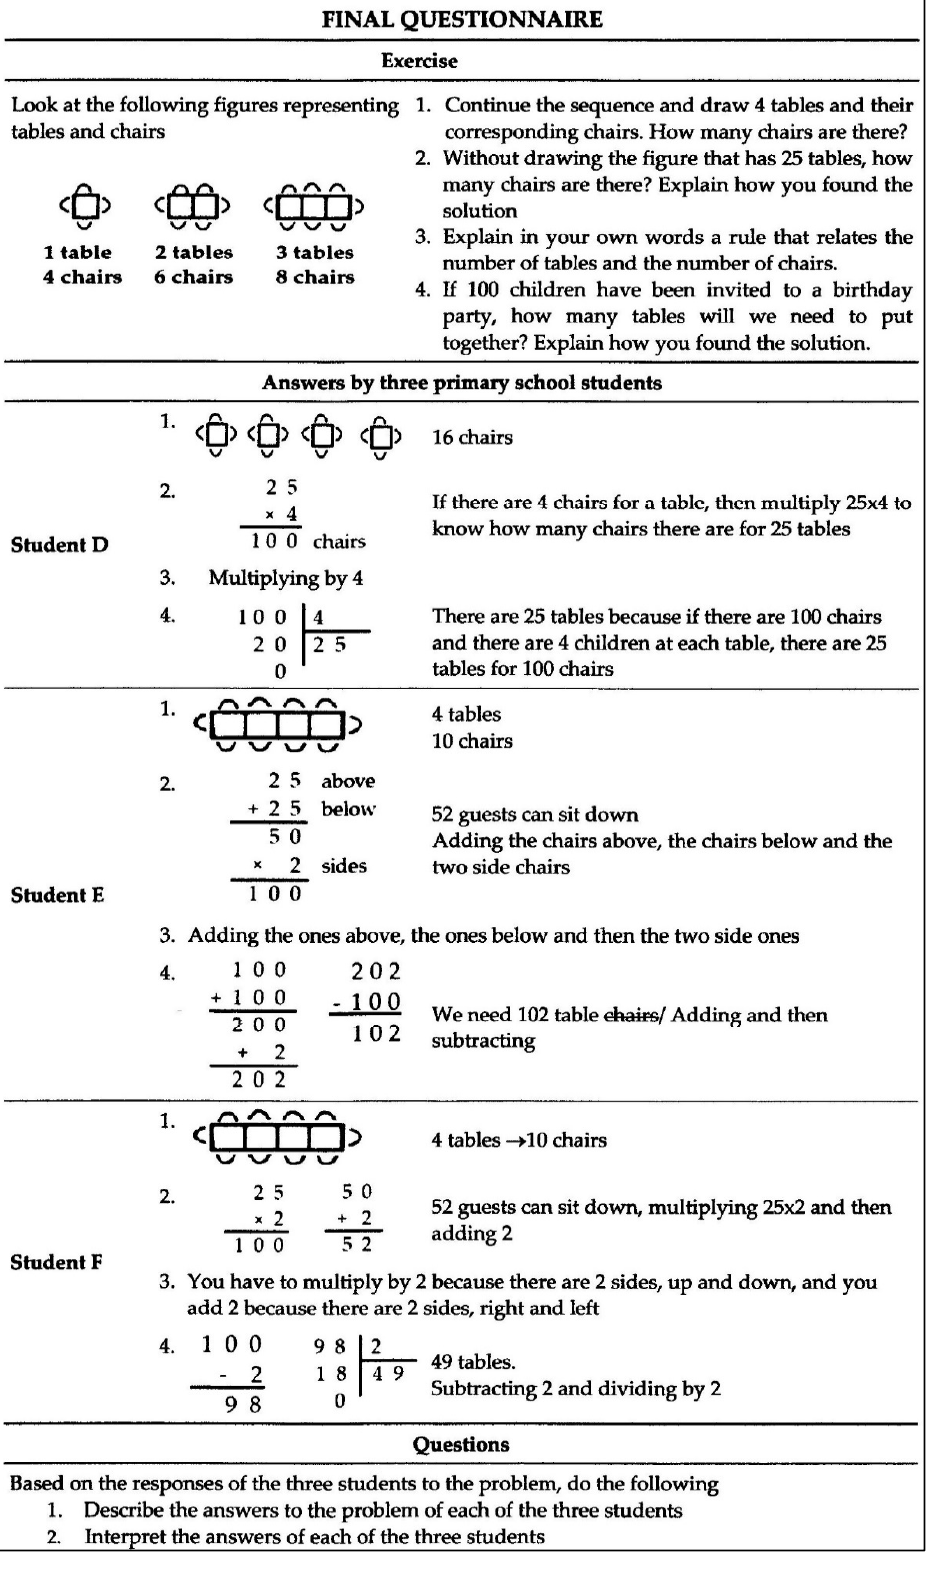
Figure 3. Final questionnaire. The students’ handwritten answers are transcribed and translated into English for better understanding by the reader.